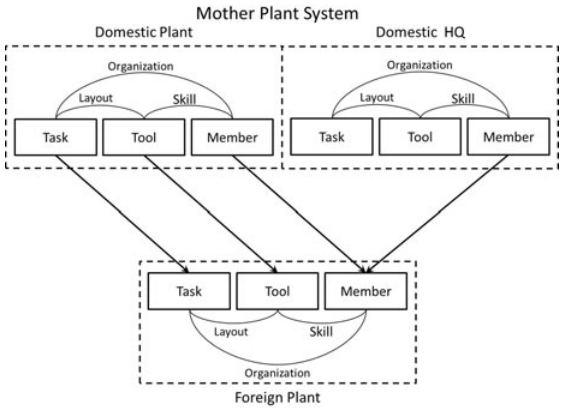
Figure 1. Knowledge transfer of mother plant